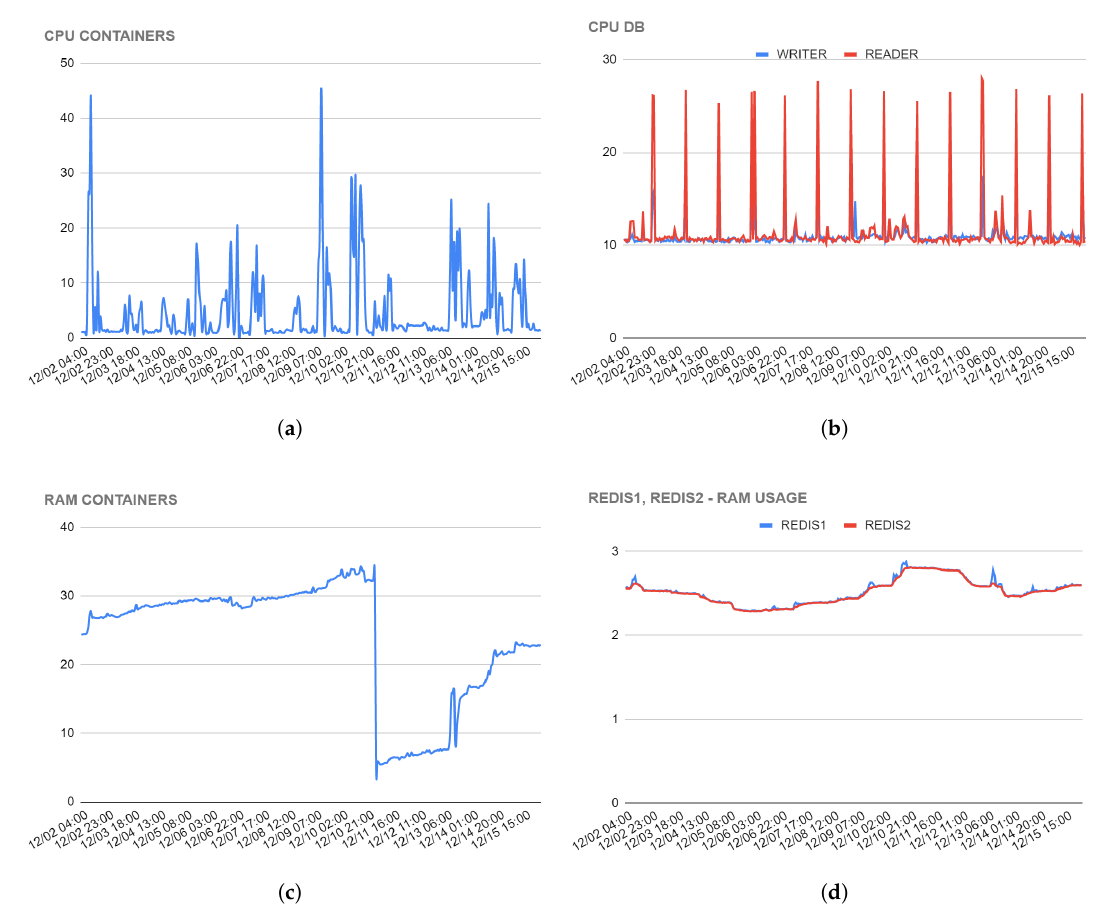
Figure 6. Average CPU and RAM usage of the clusters. ( a ) CPU usage of the Docker cluster; ( b ) CPU usage of the database cluster; ( c RAM usage of the Docker cluster) ;( d ) RAM usage of the Redis cluster.